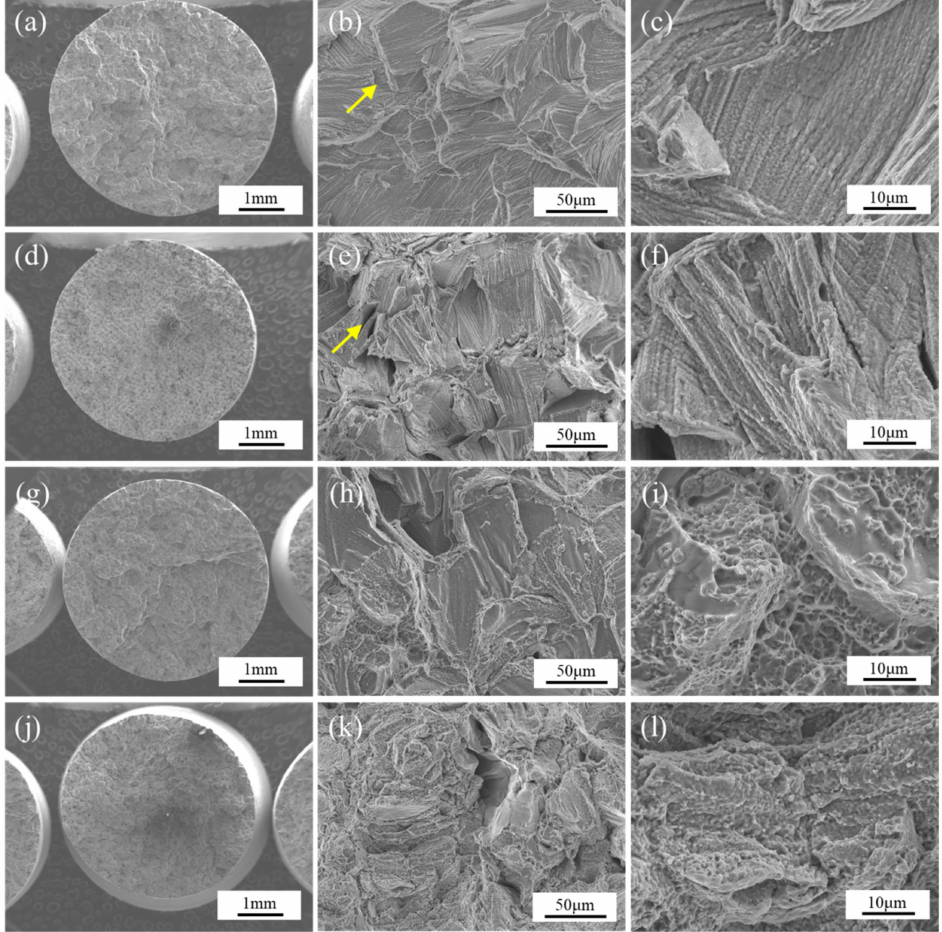
Figure 11. High-temperature tensile fracture before heat treatment: ( a – c ) transverse structure; ( d – f ) longitudinal structure; high-temperature tensile fracture- after heat treatment: ( g – i ) transverse structure; and ( j – l ) longitudinal